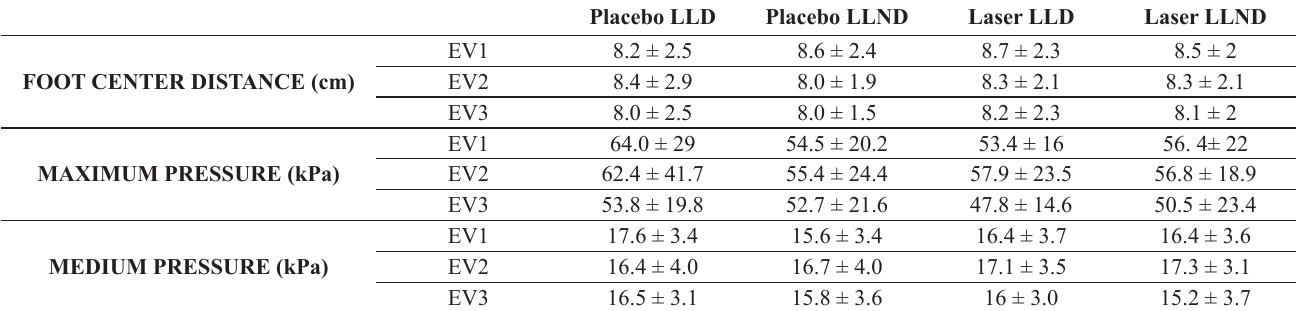
Table 1 – Baropodometry – Static Analysis. Assessments occurred in the lower limb dominant (LLD) and non-dominant